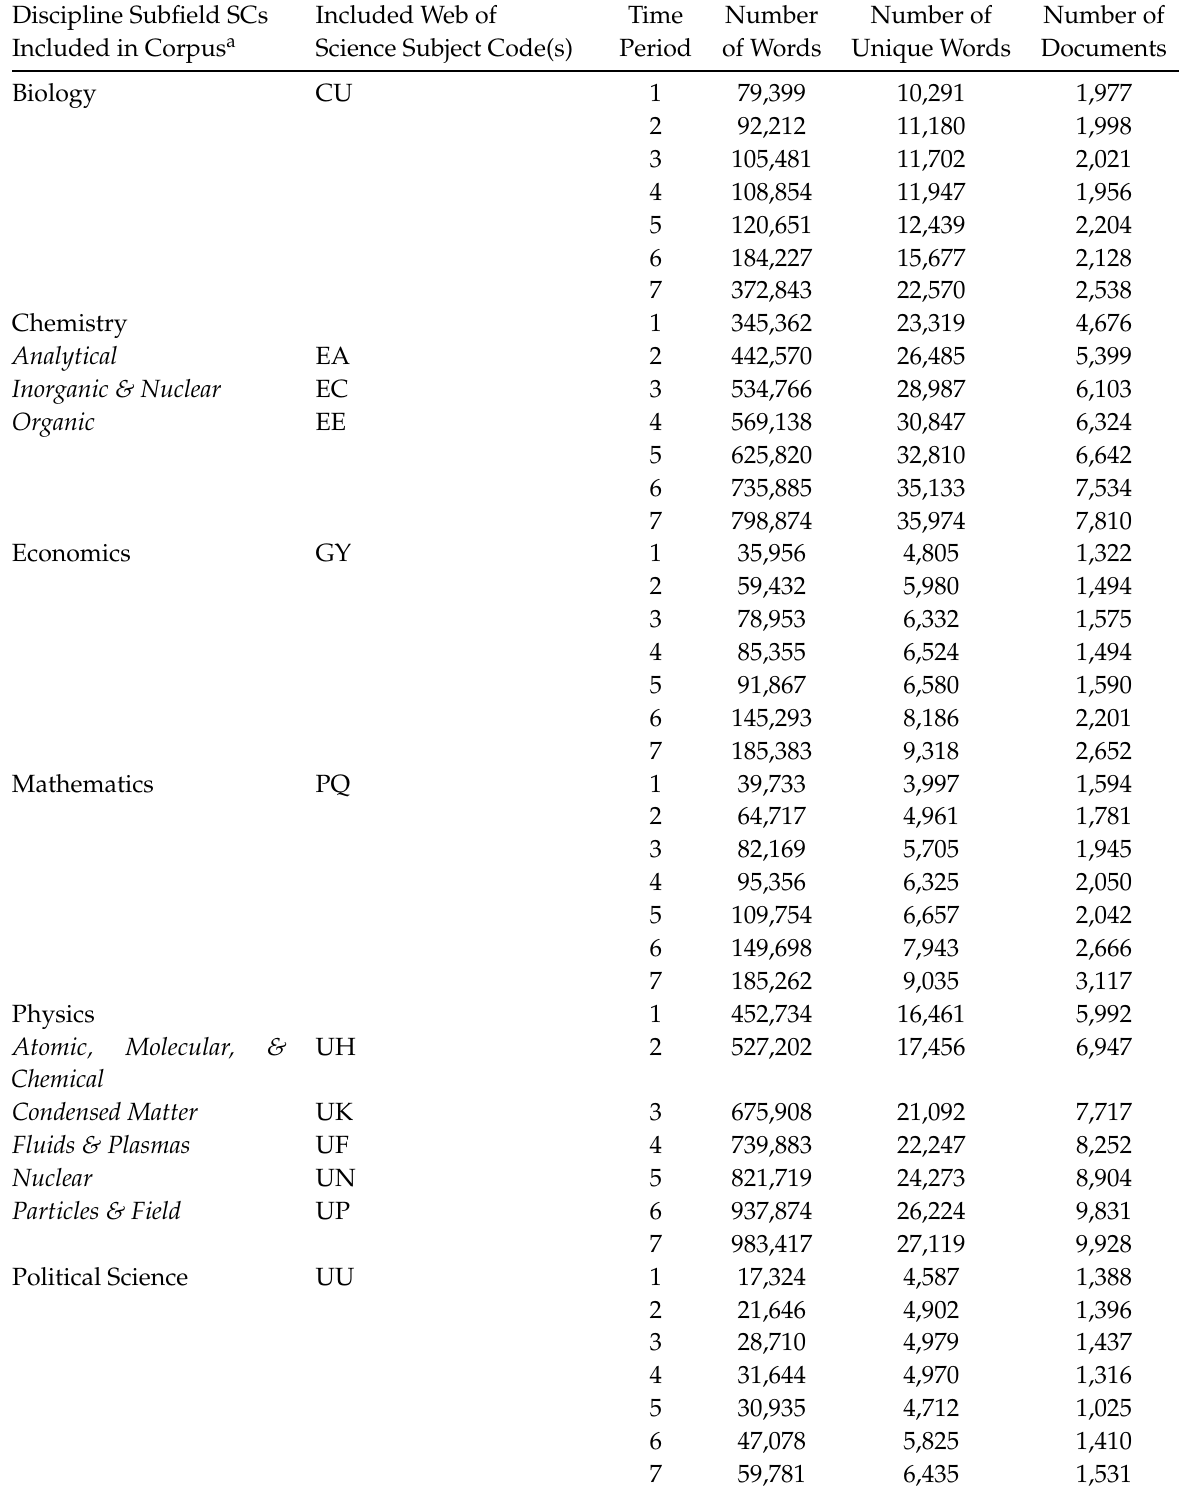
Table 1: Descriptive statistics of the eight disciplines used in the 5%